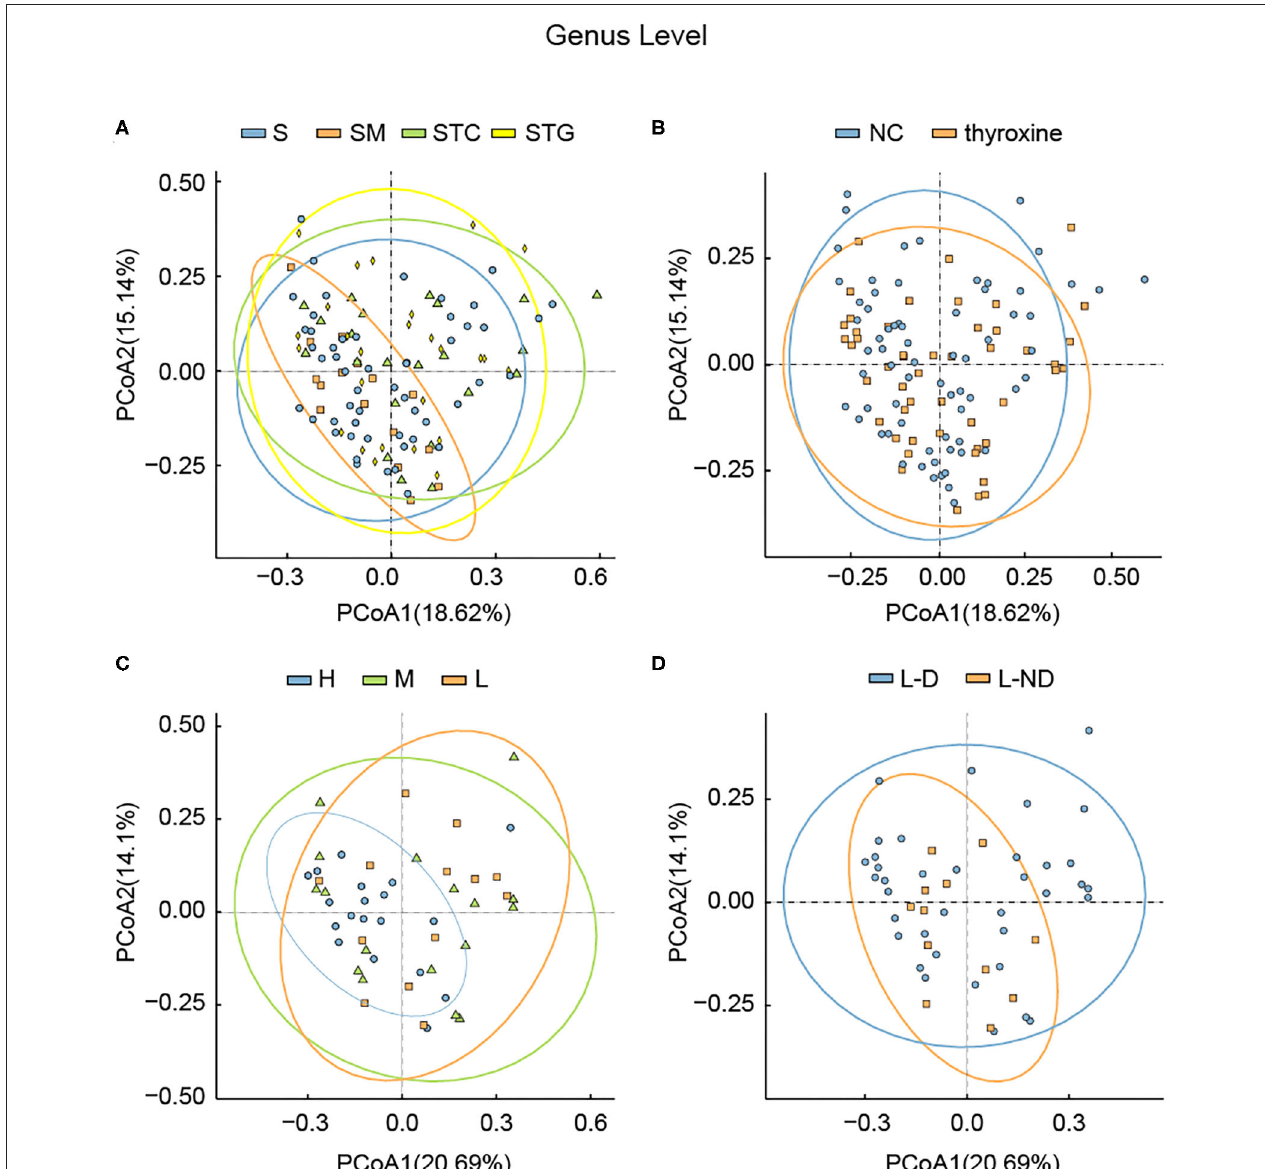
FIGURE 3 | Principle coordination analysis among different groups divided by (A) lipid profile, (B) with or without L-thyroxine treatment, (C) L-thyroxine dosage within the LRT group, and (D) the development of L-thyroxine dosage within the LRT group in genus levels. X- and Y-axes represent the first principal component (PCoA1) and the second principal component (PCoA2), respectively. The percentage in the brackets represents the relative contribution of the component to the total difference. Each sample corresponded to one dot in the graph. The circle summarized the area of gathering of the dots. Different groups, together with the circle, are represented by different